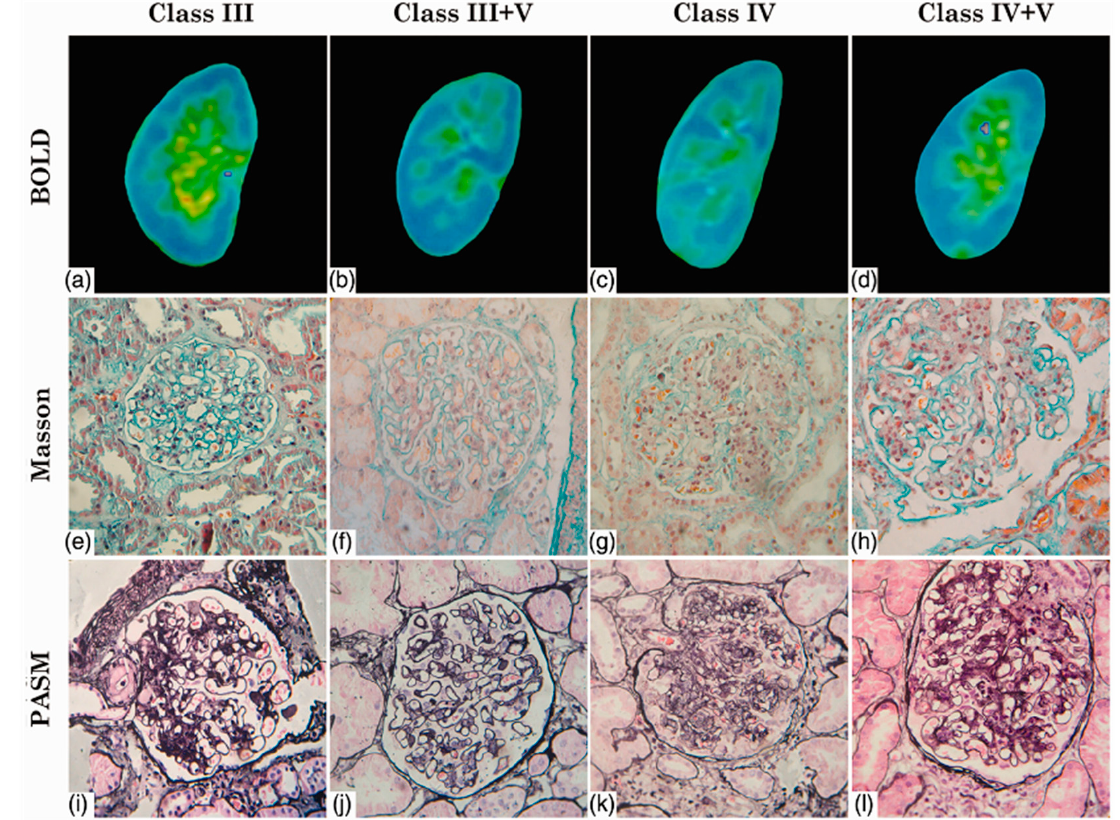
Figure 3. Use of blood oxygen level-dependent (BOLD) MRI to visualize lupus nephritis lesions with corresponding biopsy pathology specimens categorized by the International Society of Nephrology and the Renal Pathology Society (ISN/RPS) classes. ( a , e , i ) Class III; ( b , f , j ) Class III + V; ( c , g , k ) Class IV; ( d , h , l ) Class IV + V. Blue areas in ( a – d ) indicate low R2* values and oxyhemoglobin levels, with green, yellow, and red areas representing increases in both, in that respective order. Staining in ( e – h ) was done using Masson’s trichome, and staining in ( i – l ) was done using Periodic acid-Schiff-methenamine silver. (Figure reprinted with permission from SAGE publishers, from Shi et al., 2018).